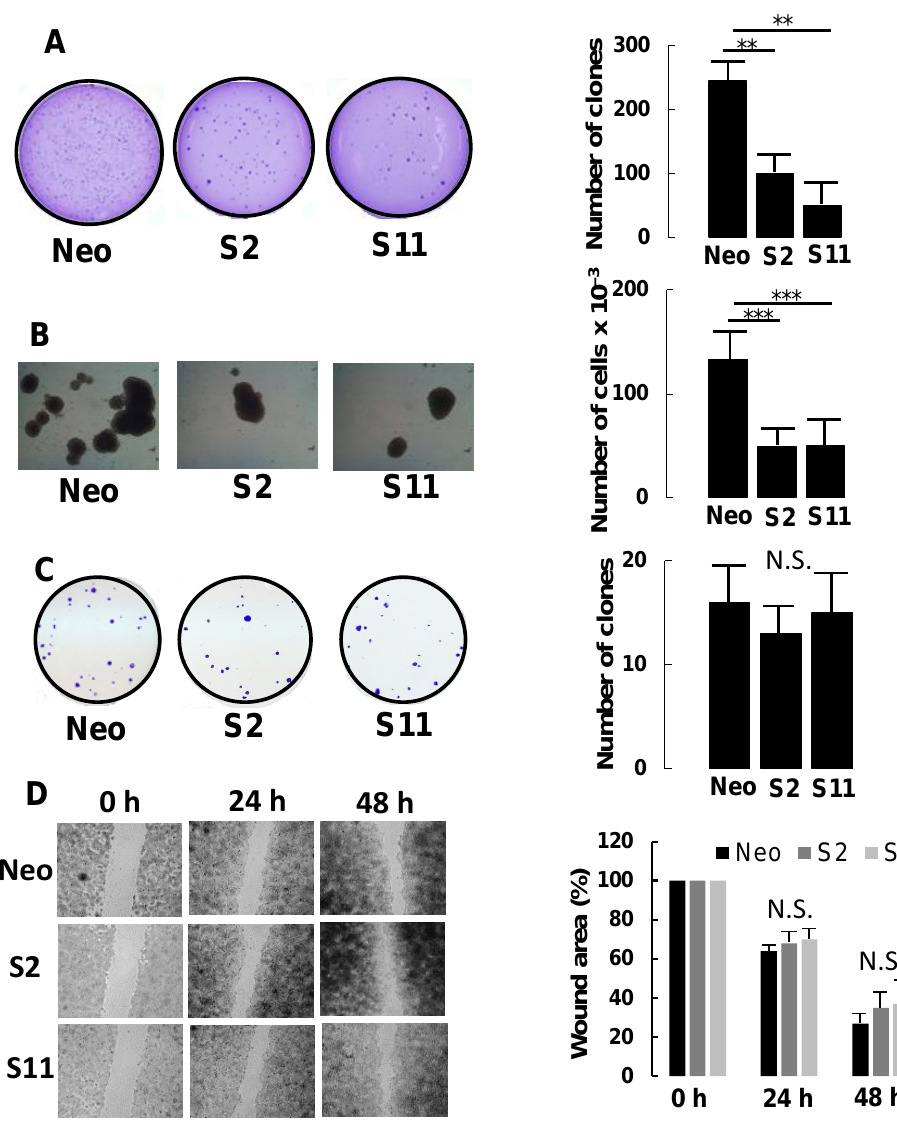
Figure 3. Phenotypic characterization of B4GALNT2-expressing cells and mock-transfectants. ( A ) growth in 0.33% agar. ( B ) tridimensional growth as spheroids. ( C ) clone formation in standard growth conditions. ( D ) wound healing assay. Experimental details are provided in Materials and Methods. ** p ≤ 0.01, *** p ≤ 0.001, N.S. = Not